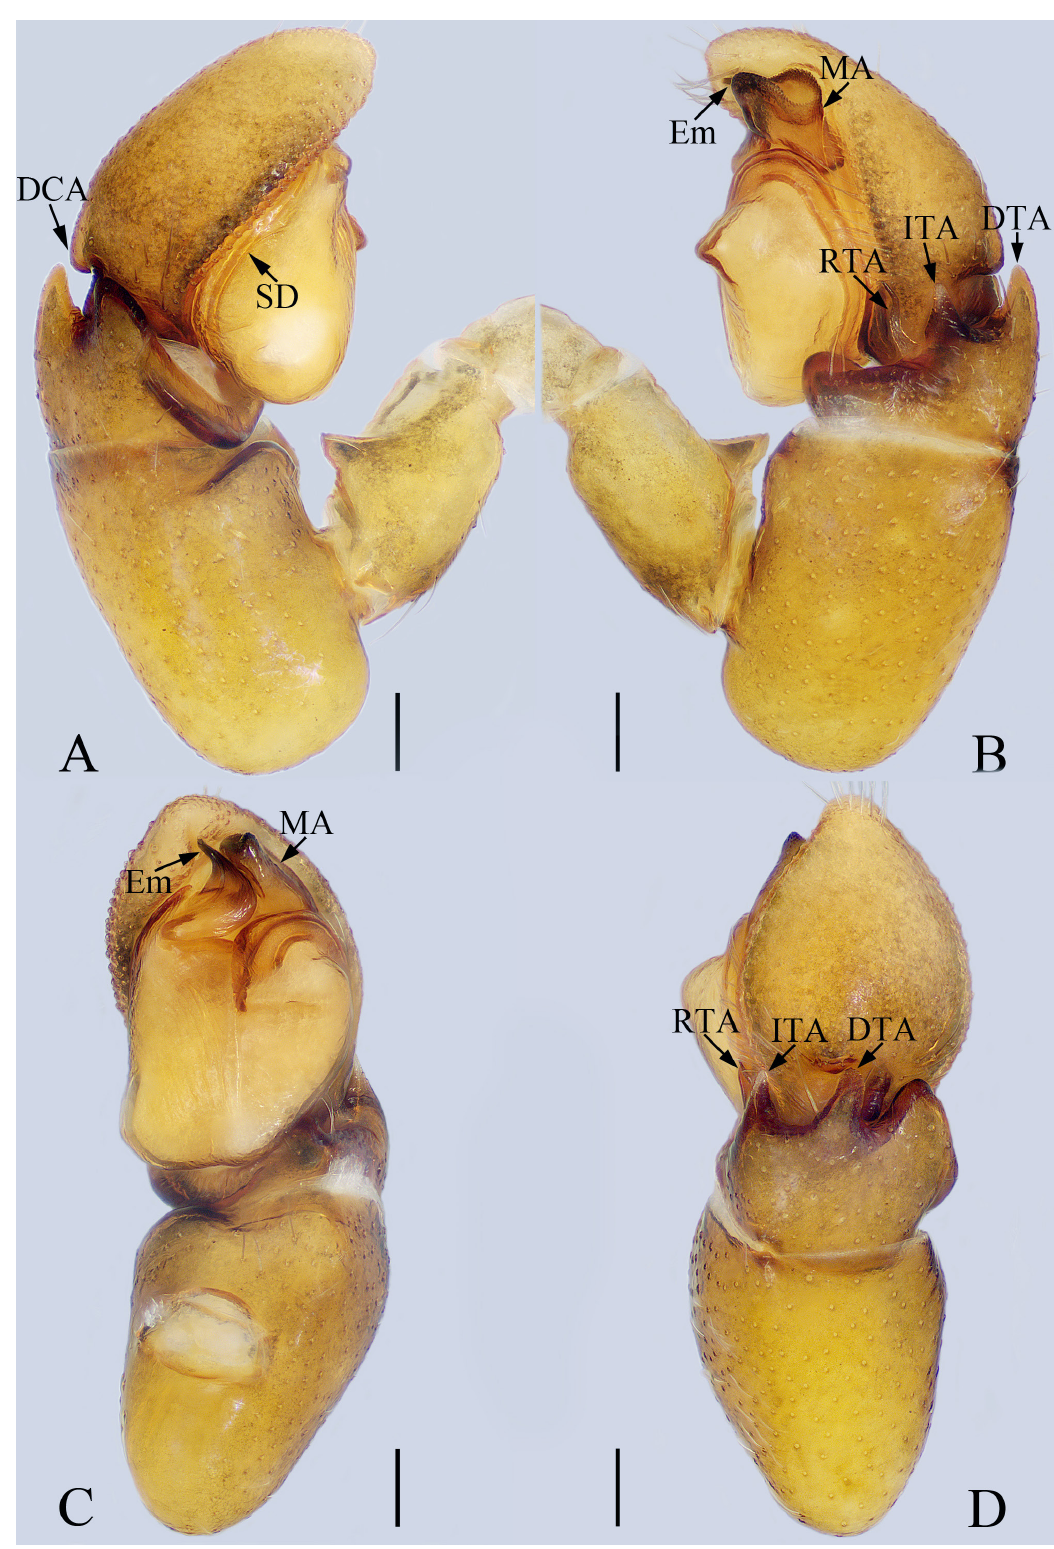
Fig. 15. Male palp of Synagelides xingdouensis sp. nov., holotype, ♂ (HNU-20170513-1). A . Prolateral view. B . Retrolateral view. C . Ventral view. D . Dorsal view. Abbreviations: see Material and methods. Scale bars = 0.1